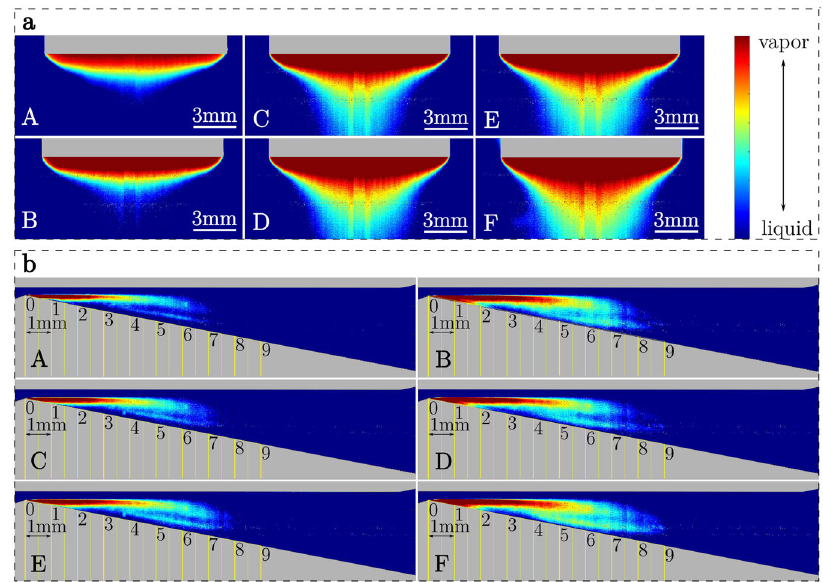
Fig. 7 Average cavitation extent under selected experimental conditions. Experimental conditions for a AC and b HC: A: H 2 O (25 °C), B: H 2 O (60 °C), C: H 2 O (25 °C) + PVOH, D: H 2 O (60 °C) + PVOH, E: H 2 O (25 °C) + PVOH + H 2 O 2 , F: H 2 O (60 °C) + PVOH + H 2 O 2 .